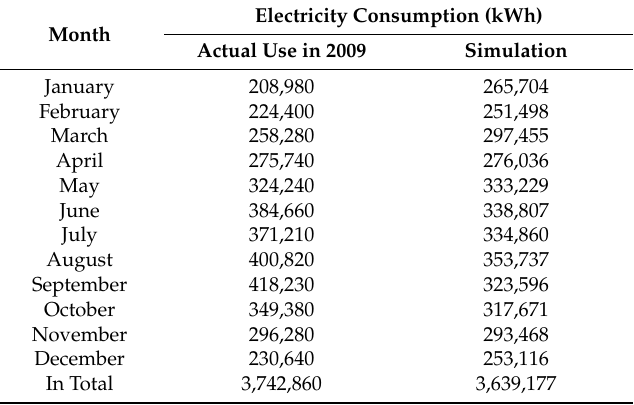
Table 6. Simulated Energy Consumption Data Compared with Actual Data in the year